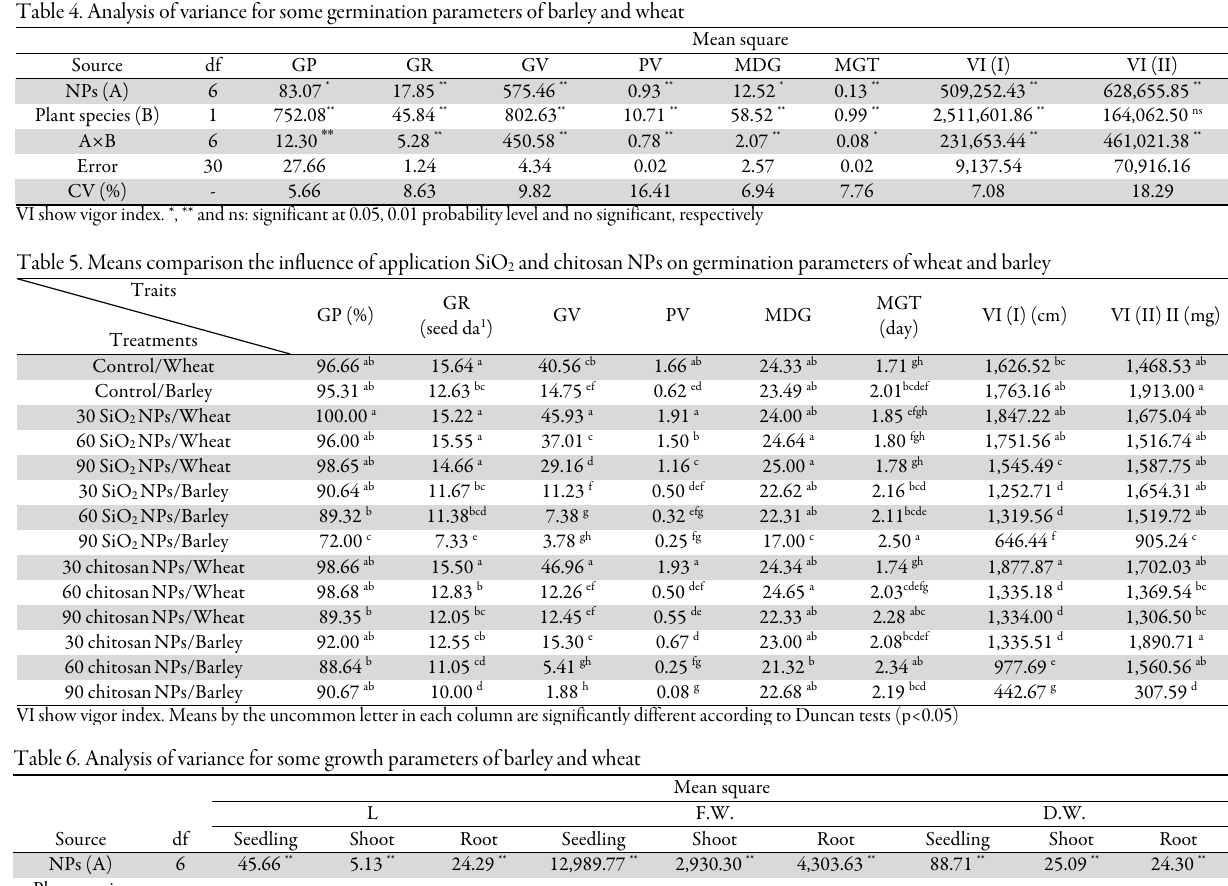
Table 4. Analysis of variance for some germination parameters of barley and wheat